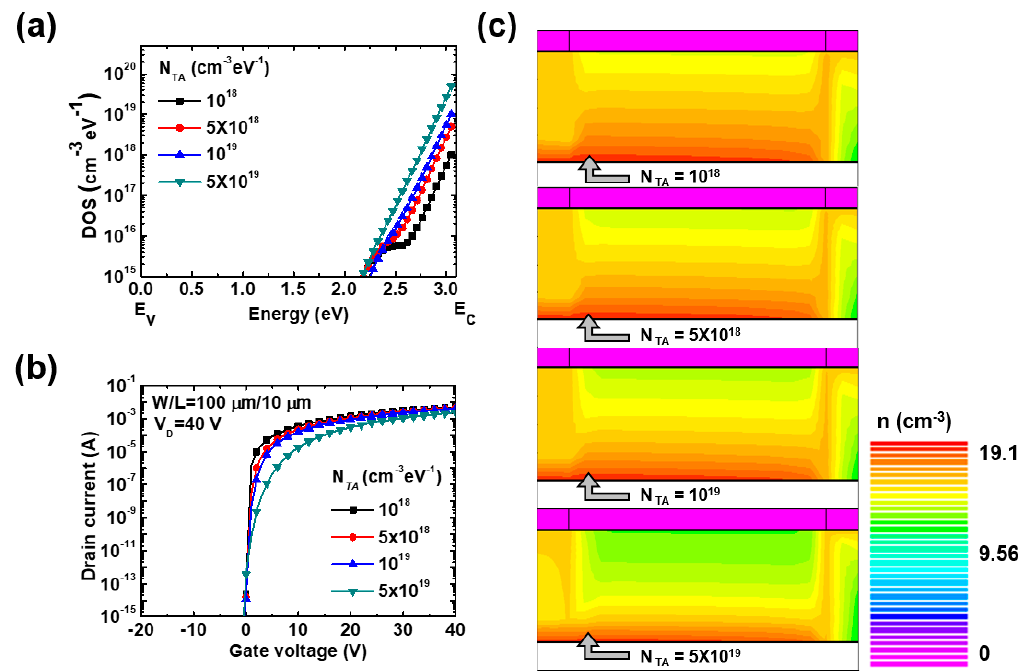
Figure 2. ( a ) Density of states (DOS) in sub-gap is shown as a function of energy. The tail acceptor-like states ( N TA ) are controlled from 10 18 to 5 × 10 19 cm − 3 eV − 1 . ( b ) Drain current according to the applied gate voltage is shown at 40 V of drain voltage. ( c ) Each layer depicts the electron concentration distribution from top to bottom of N TA in the range of 10 18 to 5 × 10 19 cm − 3 eV − 1 at the saturation region 40 V of gate voltage, and 40 V of drain voltage. The color table displays the electron concentration variations of 0–10 19.1 in varying colors.